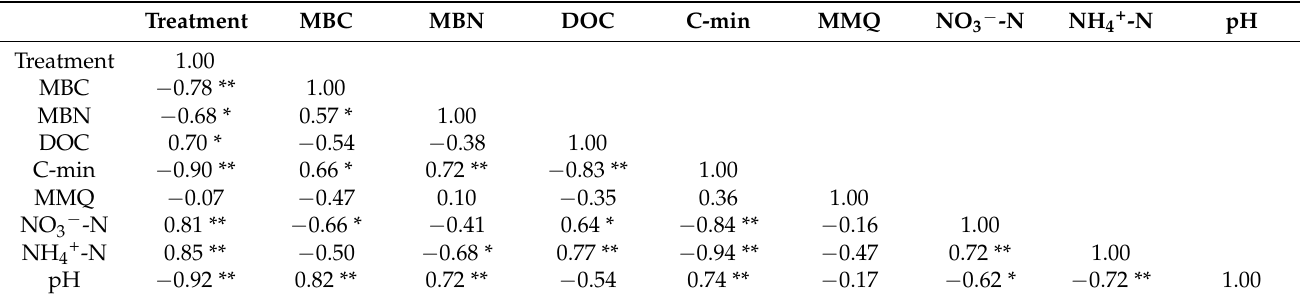
Table 2. Pearson correlation coefficients between N treatment, soil carbon mineralization, soil microbial biomass, and soil properties across all the plots.